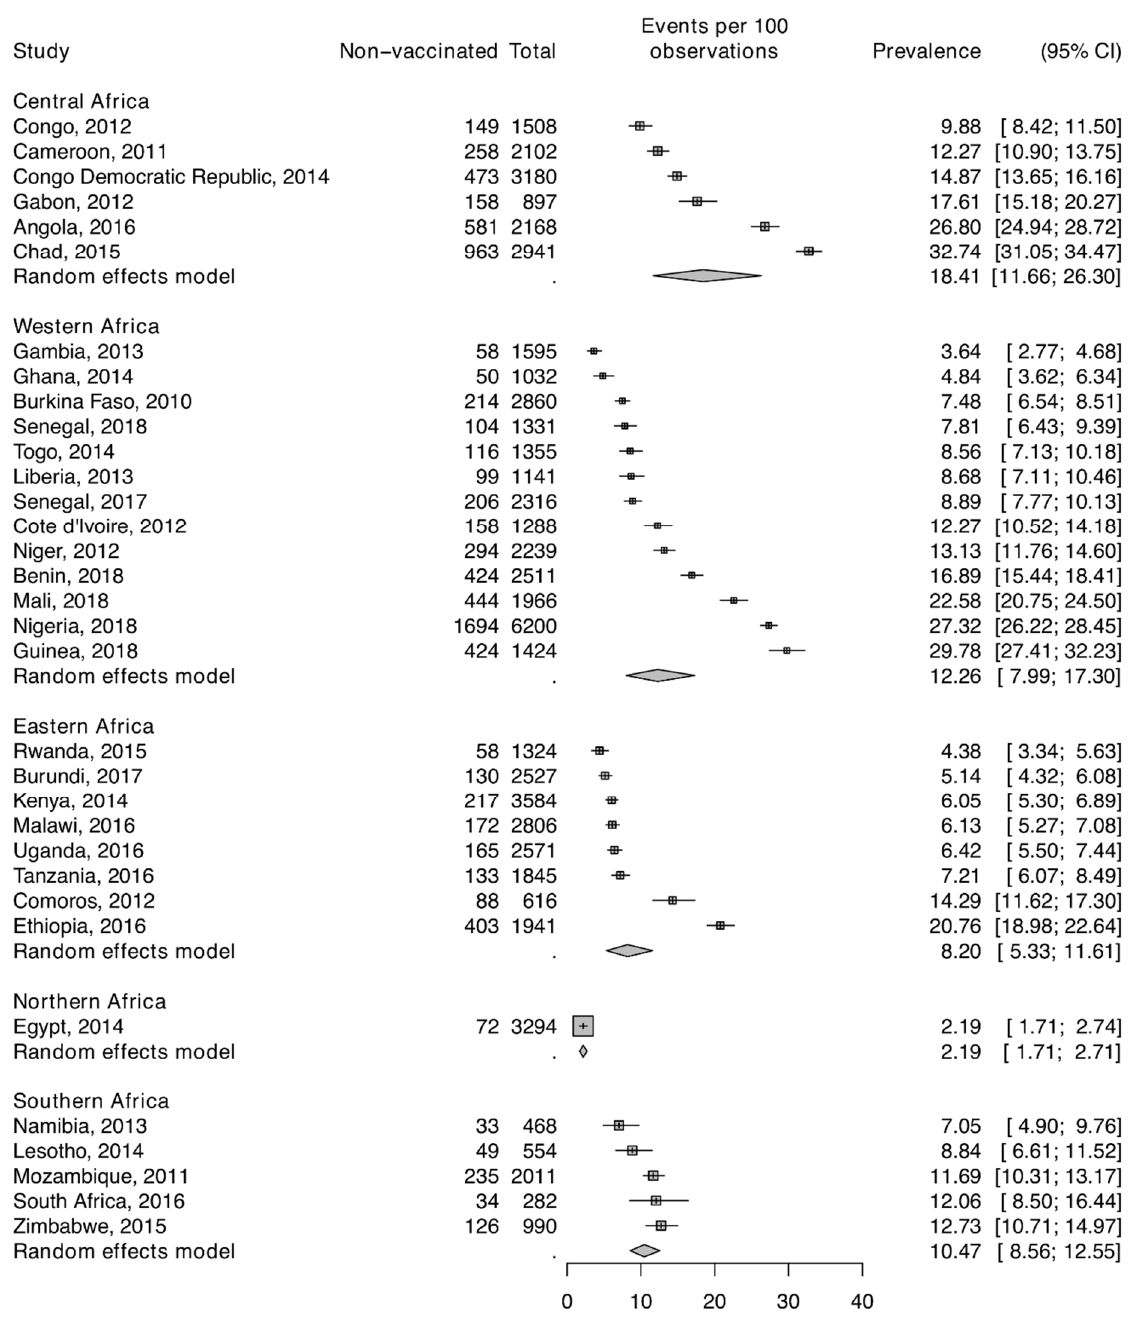
Figure 1. Prevalence in non-vaccination for polio across African regions.